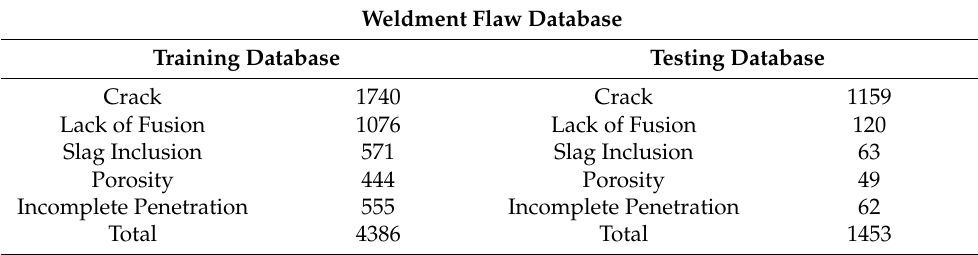
Table 3. Ultrasonic weldment flaw database.